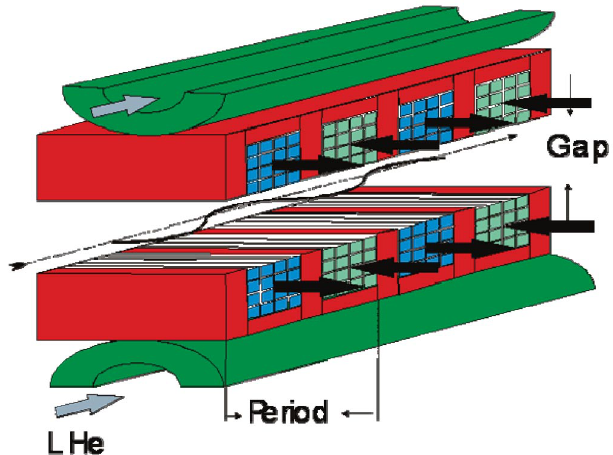
FIG. 1. (Color) Schematic layout of a superconductive in- vacuum undulator used for this experiment. The current direc- tion in the wires alters. The undulator can be cooled indirectly either by liquid helium or a cryocooler. The arrows mark the direction of the current.